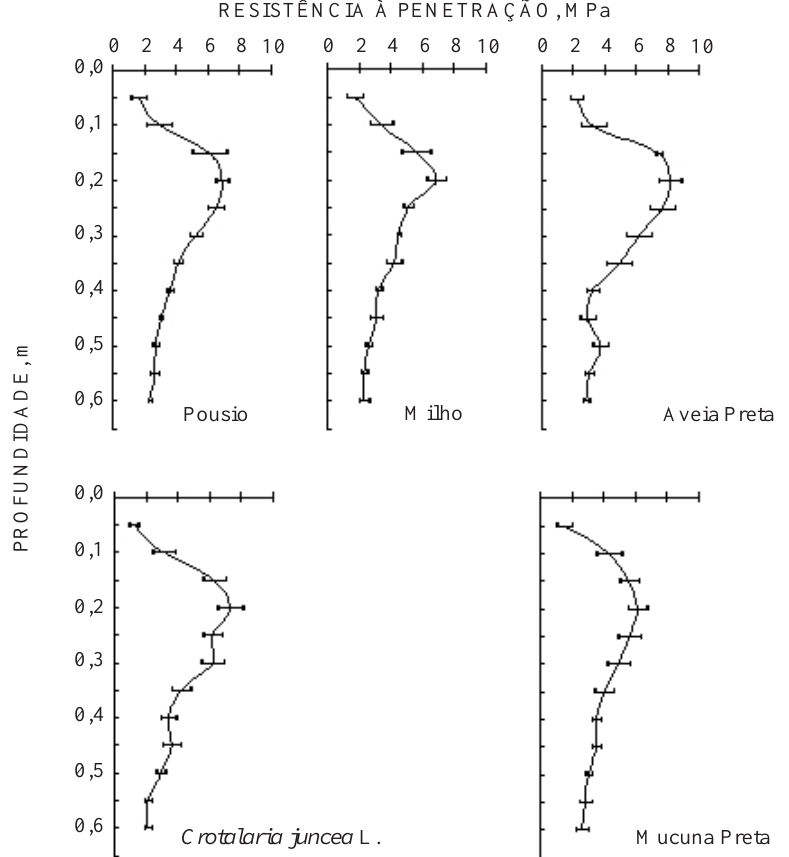
Crotalaria juncea Figura 1. Valores médios de resistência à penetração ± erro-padrão da média, em MPa, com penetrômetro de impacto modelo IAA/PLANALSUCAR, em diferentes profundidades, em Latossolo Vermelho eutroférrico típico cultivado com feijoeiro e após rotação com culturas graníferas e adubos verdes.